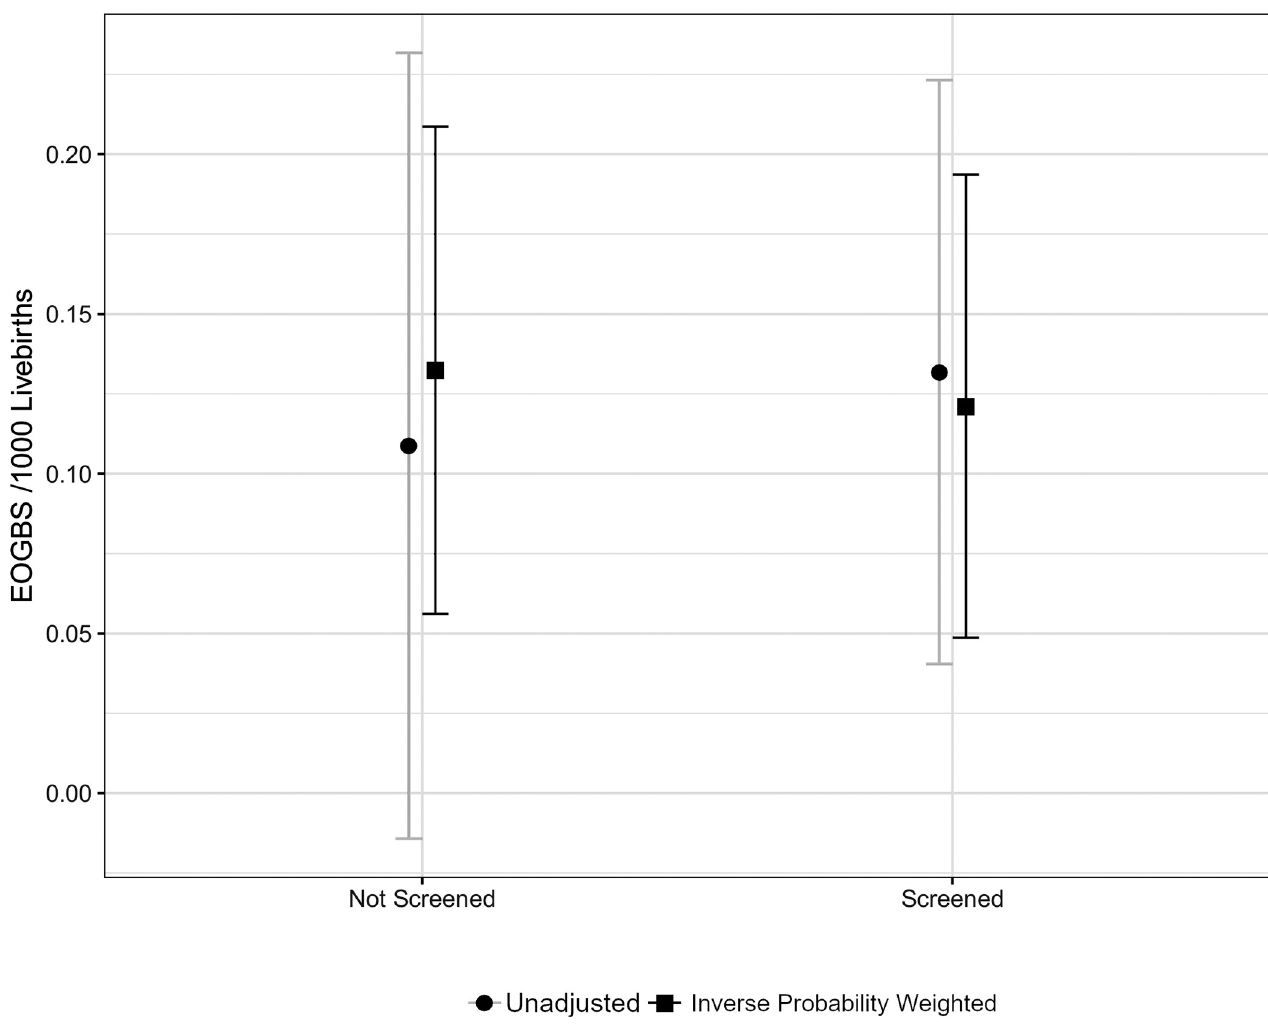
Fig 3. Screened versus unscreened pregnancies and rates of EOGBS. EOGBS = early-onset group B streptococcal infection.